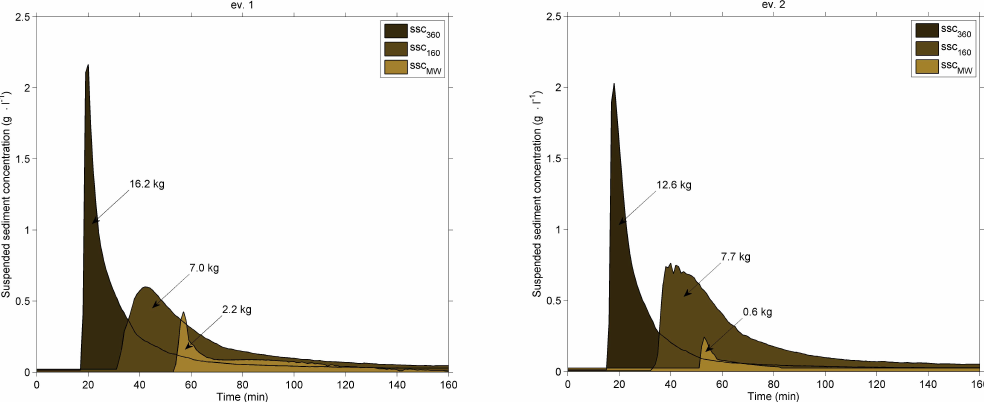
Fig. 7. Sedigraphs of the first (ev.1) and second (ev.2) flooding experiments at the three monitoring locations (see Fig. 2).